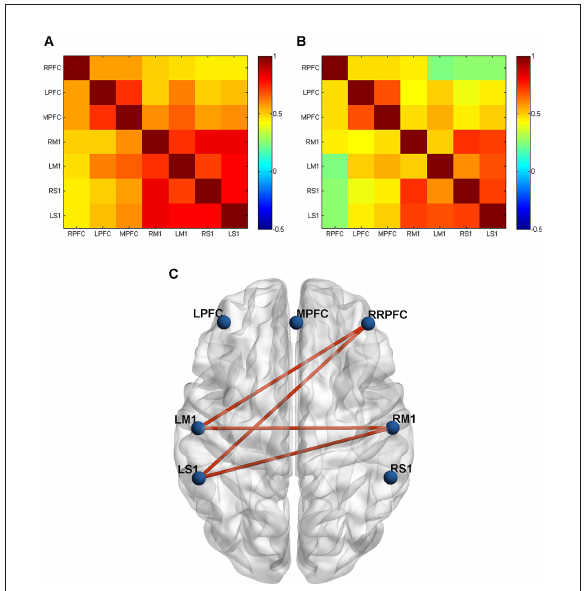
FIGURE3 Grand-averaged correlation matrix of all ROI pairs in two groups: (A) CCNMES group; (B) NMES group. Axes represent the regions. Each channel with its correlation coefficient set at zero (the diagonal line). RPFC, right prefrontal cortex; LPFC, left prefrontal cortex; MPFC, middle prefrontal cortex; RM1, right primary motor cortex; LM1, left primary motor cortex; RS1, right primary sensory cortex; LS1, left primary sensory cortex. (C) The inter-group differences in actual ROIs represented by automated anatomical labelling (AAL) atlas in axial view. The blue nodes represent the seven regions of interest. The red lines represent connections with significant differences between the CCNMES group and the NMES group (all p <